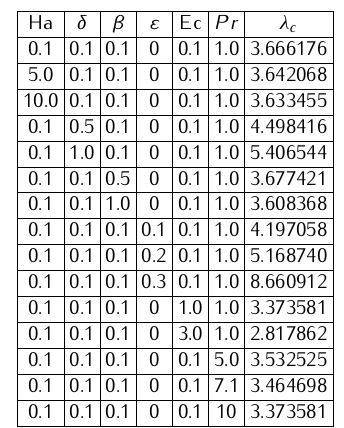
Table 1. Computationsshowingthermalcriticalityfordifferentparam- eter